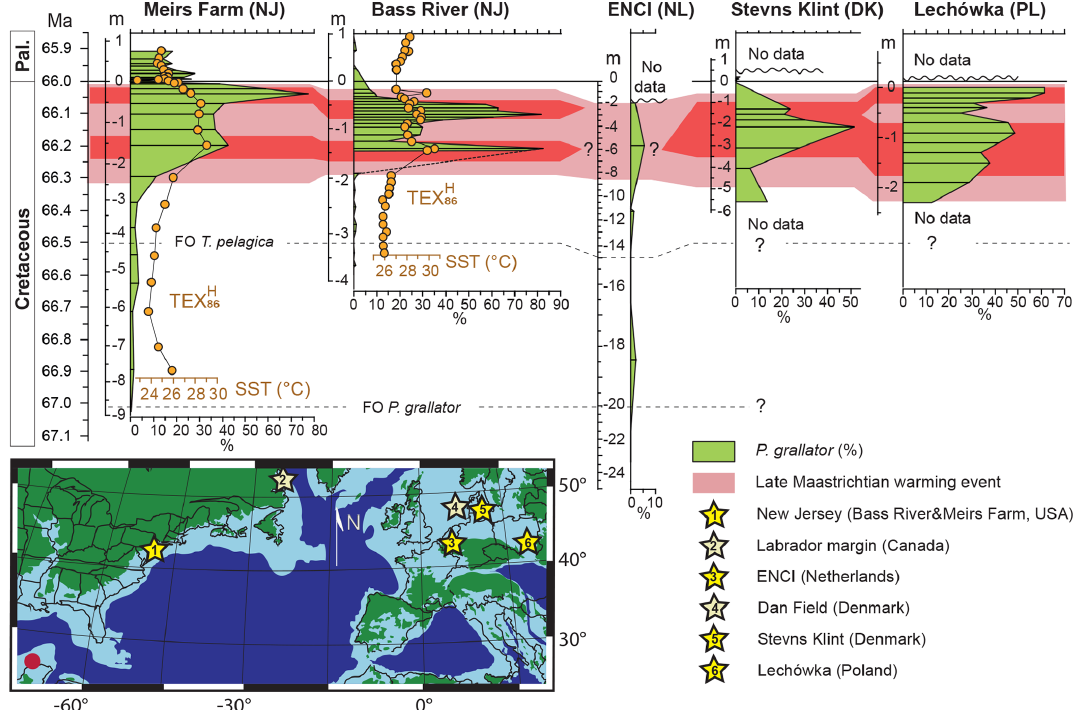
Figure 5. Palynodinium grallator acme across the boreal bioprovince. Relative abundances of P. grallator through the last million years of the Cretaceous on the New Jersey Paleoshelf (this study), the Maastrichtian type area (Schiøler et al., 1997); Stevns Klint (Denmark; Vellekoop et al., 2018) and Lechówka (Machalski et al., 2016). For ENCI, Stevns Klint and Lechówka, the peak warmth is inferred based on the P. grallator abundances. The red dot marks the Chicxulub impact site. Peak abundances of P. grallator in the topmost Maastrichtian are also recorded in the qualitative records of the Labrador margin (Canada; Nøhr-Hansen et al., 2016) and the North Sea Dan field (Schiøler and Wilson,